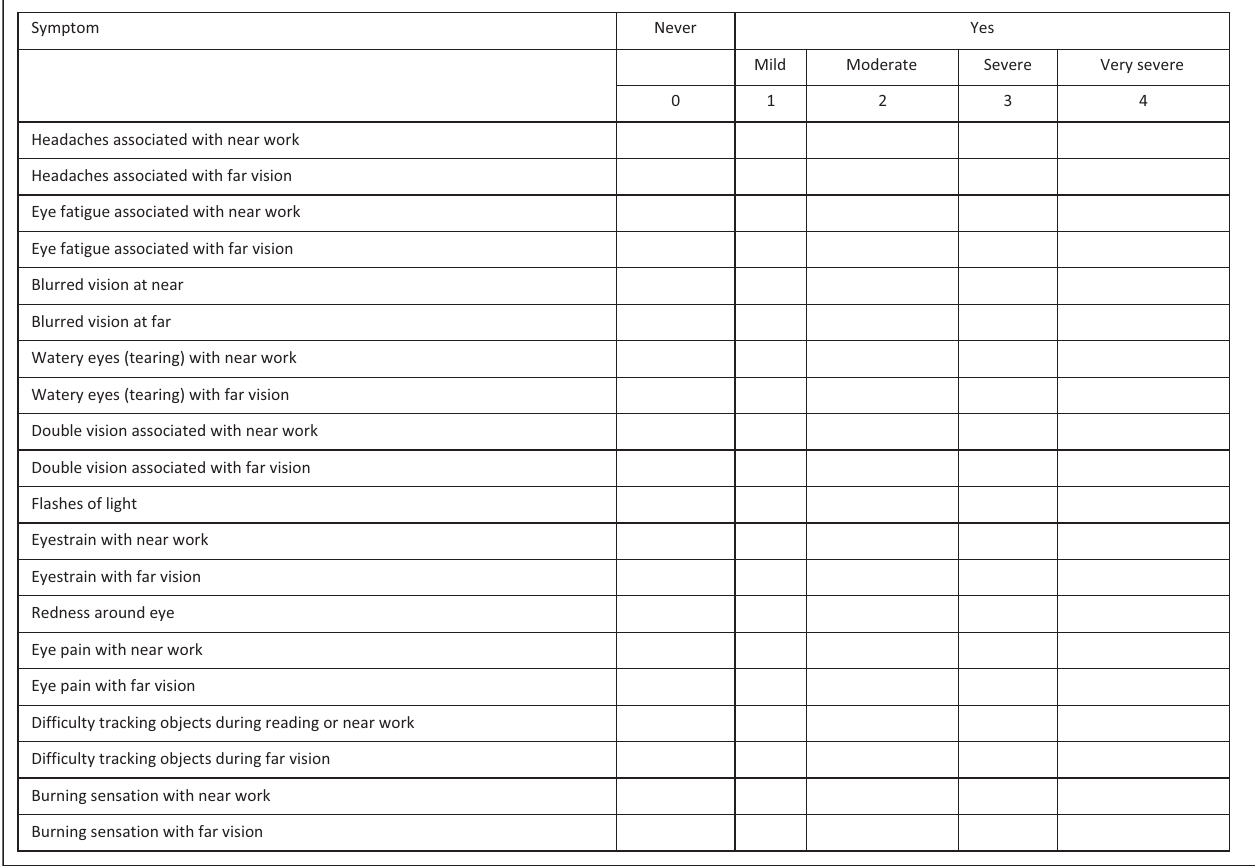
FIGURE 1: Questionnaire on asthenopic